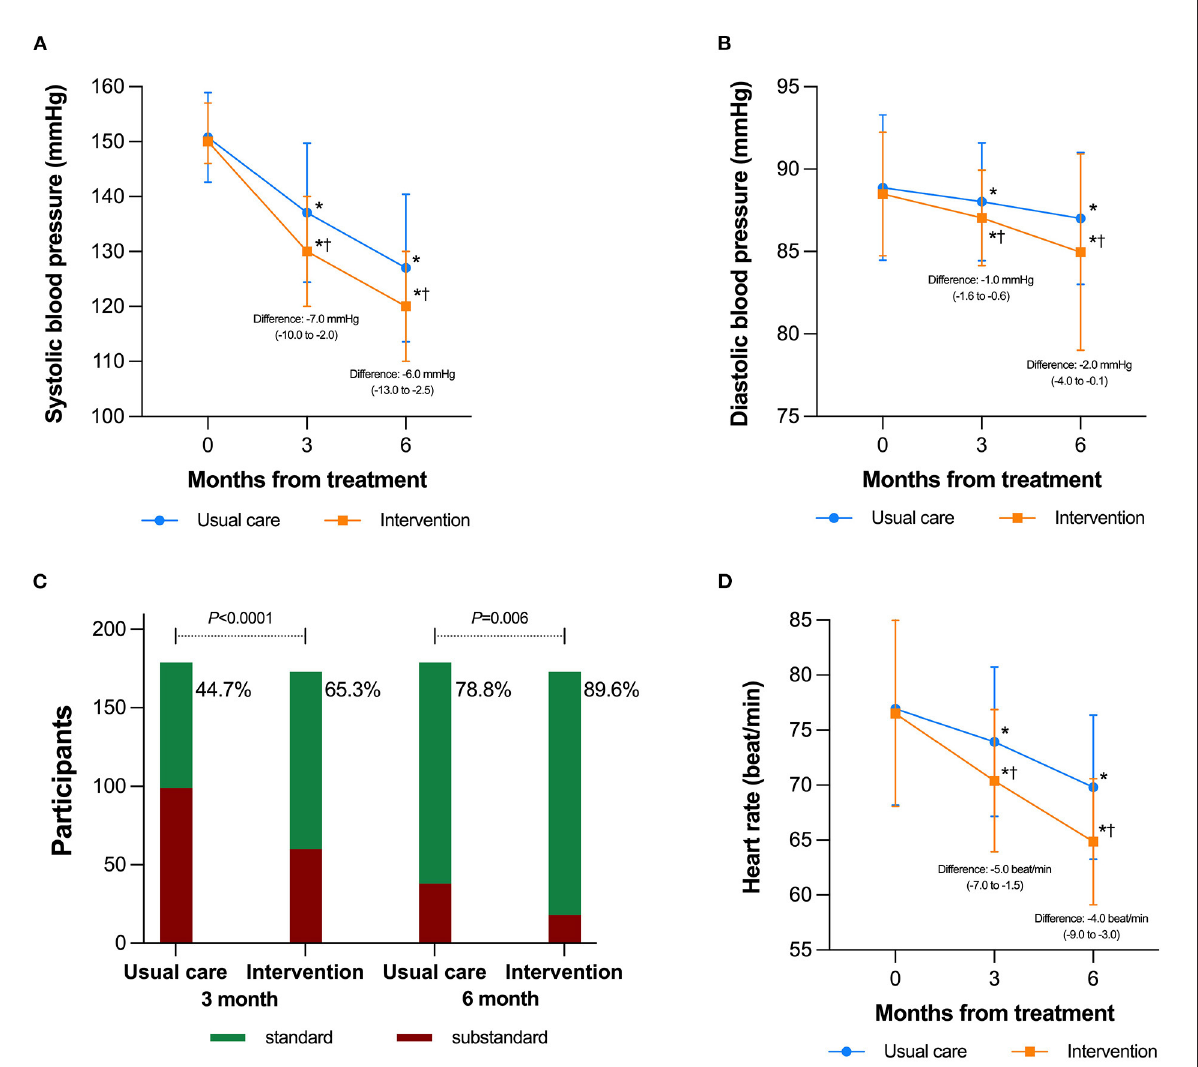
FIGURE2 Blood pressure changes during the study period by group. (A) Mean values and standard deviations in systolic blood pressure (mmHg) among all participants; (B) Mean values and standard deviations in diastolic blood pressure (mmHg) among all participants; (C) Percentage of subjects achieving treatment goal; (D) Changes in heart rate, which were presented as mean and standard deviations (error bar). * P < 0.05 within group vs. baseline value; † P < 0.05 compared the intervention group with the usual care